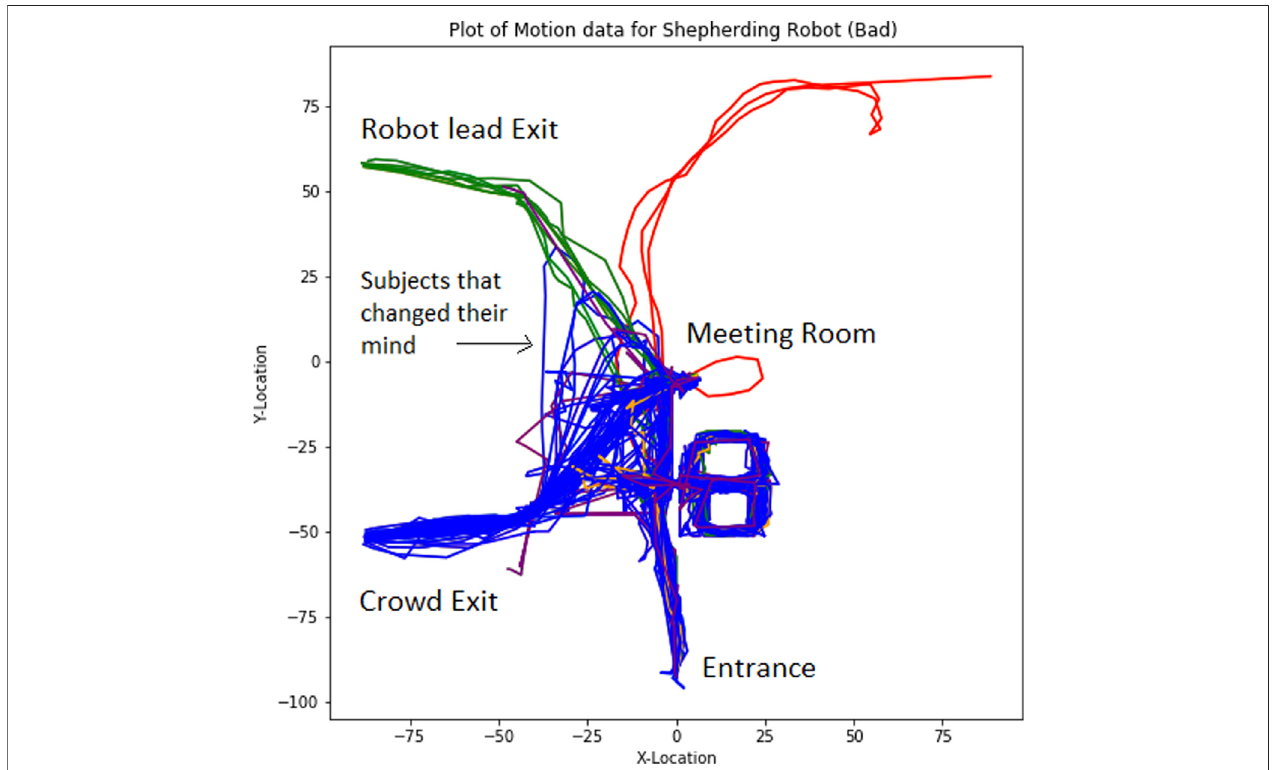
FIGURE 8 | A map of subject movements (60 subjects are depicted). The blue lines depict movement following a crowd of evacuees. The green line depicts subjects that followed the robot. Notice some blue lines appear to initially move toward the robot exit, before following the crowd.